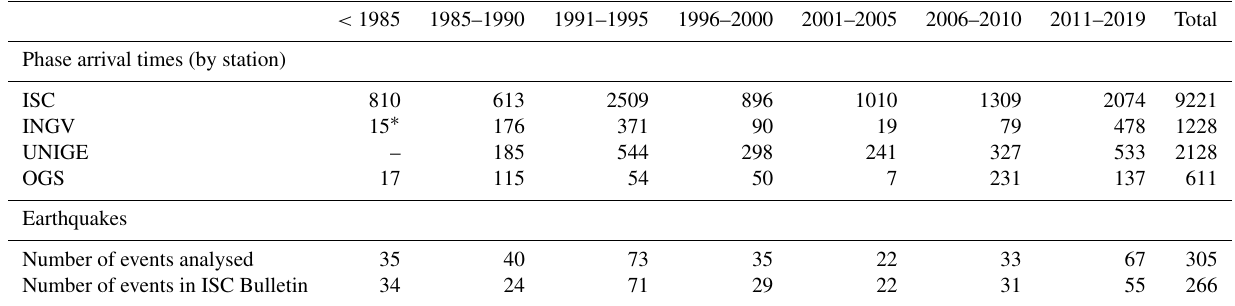
Figure 7. Power spectral density of continuous seismic signal recorded by a set of stations in the study area. The two panels show the average of the horizontal components (a) and the vertical component (b) , respectively. Thin blue lines: 1d continuous signal recorded by 13 temporary stations deployed within the ED area in July 2016; thick red line: 1 week of continuous signal recorded in the same period at the MILN station belonging to the national network managed by INGV. The dark grey lines show the two reference curves known as NHNM and NLNM by Peterson (1993), used for estimating the quality of the signal recorded by a seismological station. Table 1. Summary table of the phases/events gathered by four data providers in different time frames. As multiple phase readings for the same stations are sometimes provided, for example in ISC archives, the number of available arrival times are counted by stations. <